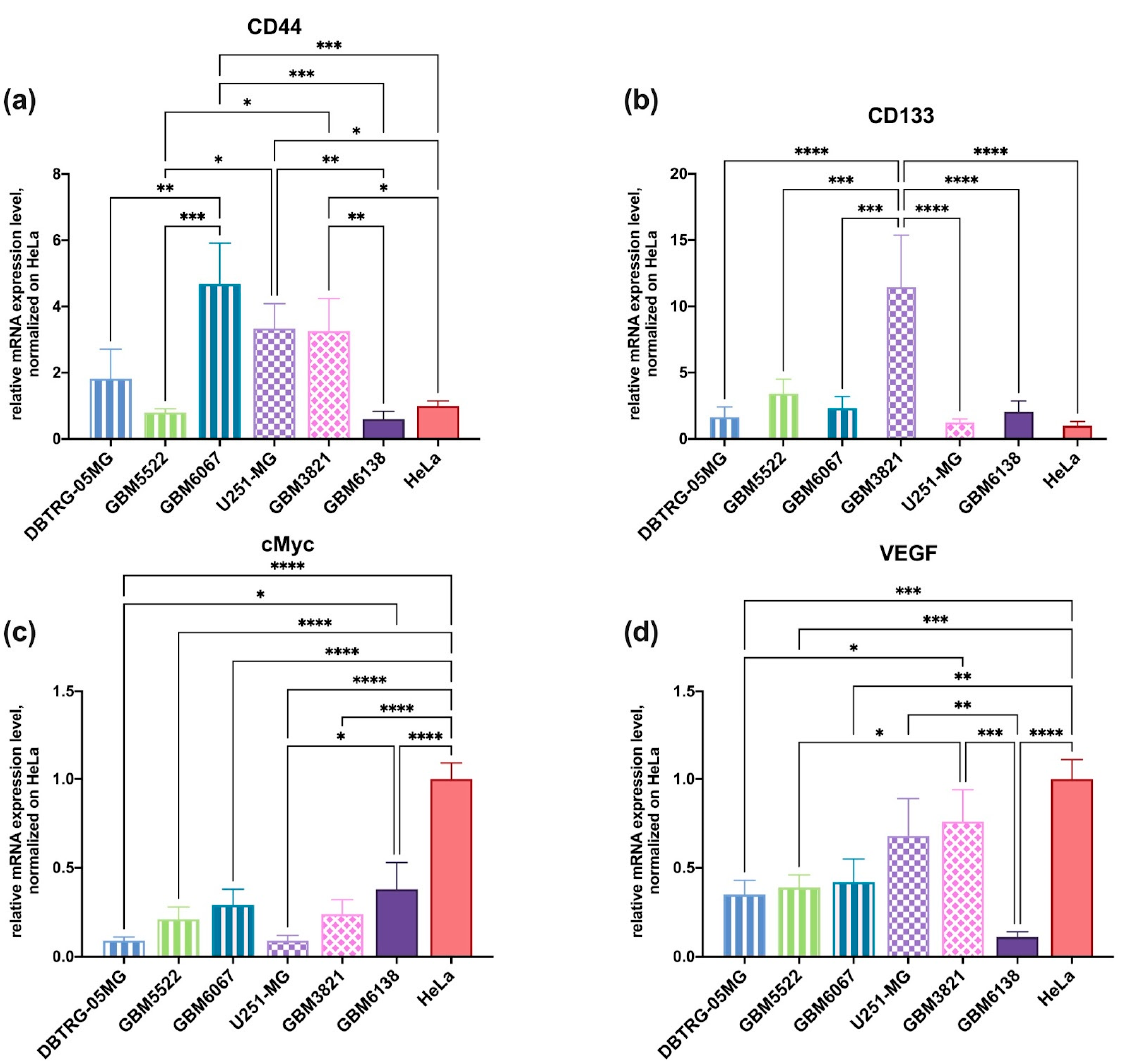
Figure 12. Levels of transcription of genes that are the markers of cancer stem cells. The cells were cultivated in standard condition, and CD44 ( a ), CD133 ( b ), cMyc ( c ) and VEGF ( d ) mRNA levels were assessed by RT-qPCR, GUS mRNA levels were used for normalization. The data were analyzed using ∆∆ Ct methods, normalized to HeLa cells line. Values are means ± S.D. * p ≤ 0.05, ** p ≤ 0.01, *** p ≤ 0.001, **** p ≤ 0.0001.